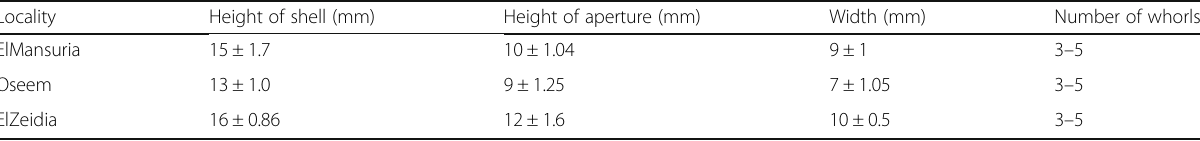
Table 1 Measurements (mm) of Lymnaea natalensis shells collected from three field localities. Random samples of snails were measured from each locality Locality Height of shell (mm) Height of aperture